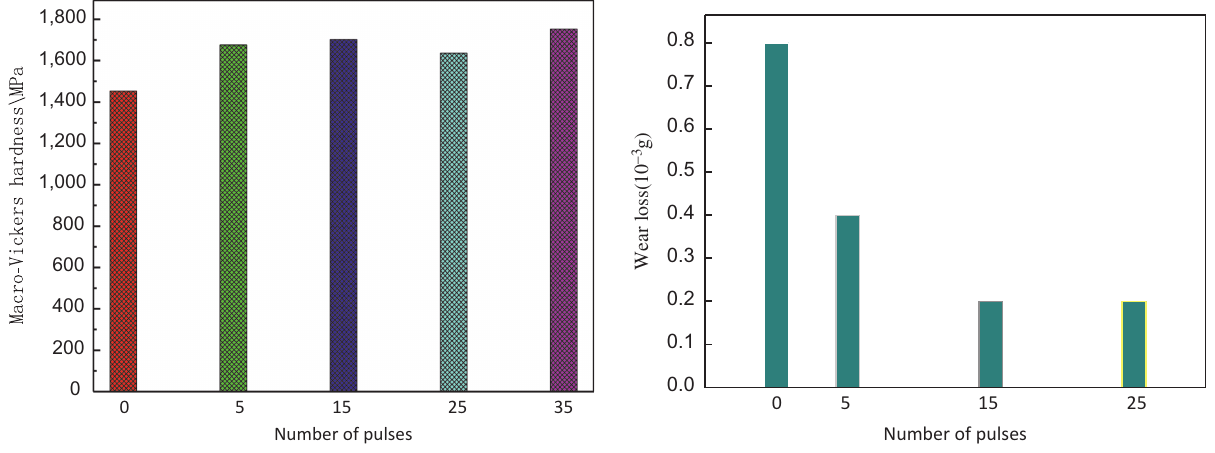
Figure 4: Evolution of macro-hardness of hypoeutectic Al – 10Si alloy with number of pulses.